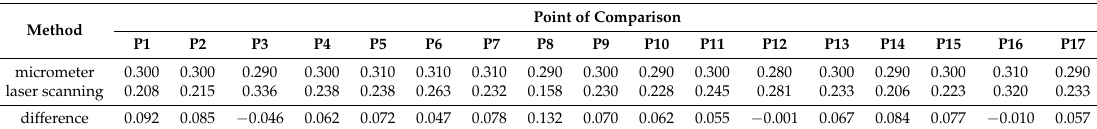
Figure 8. Comparison of the angle of incidence (left) and the leaf thickness (right) for a sugar beet leaf. Table 5. Comparison of the invasive measured leaf thickness and the laser scanning result of the sugar beet leaf shown in Figure 8 (right). Units: